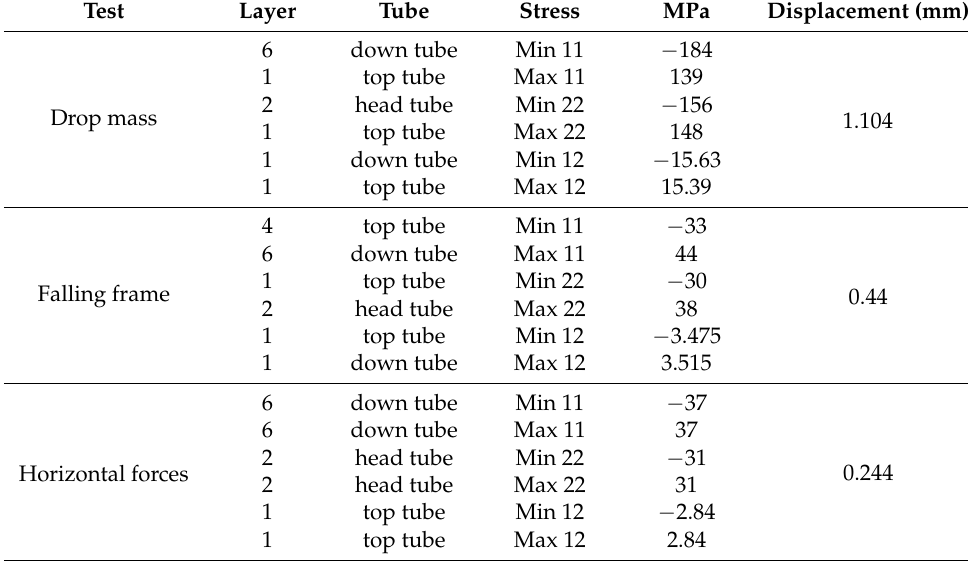
Table 20. Stress and displacement results of stacking scenario